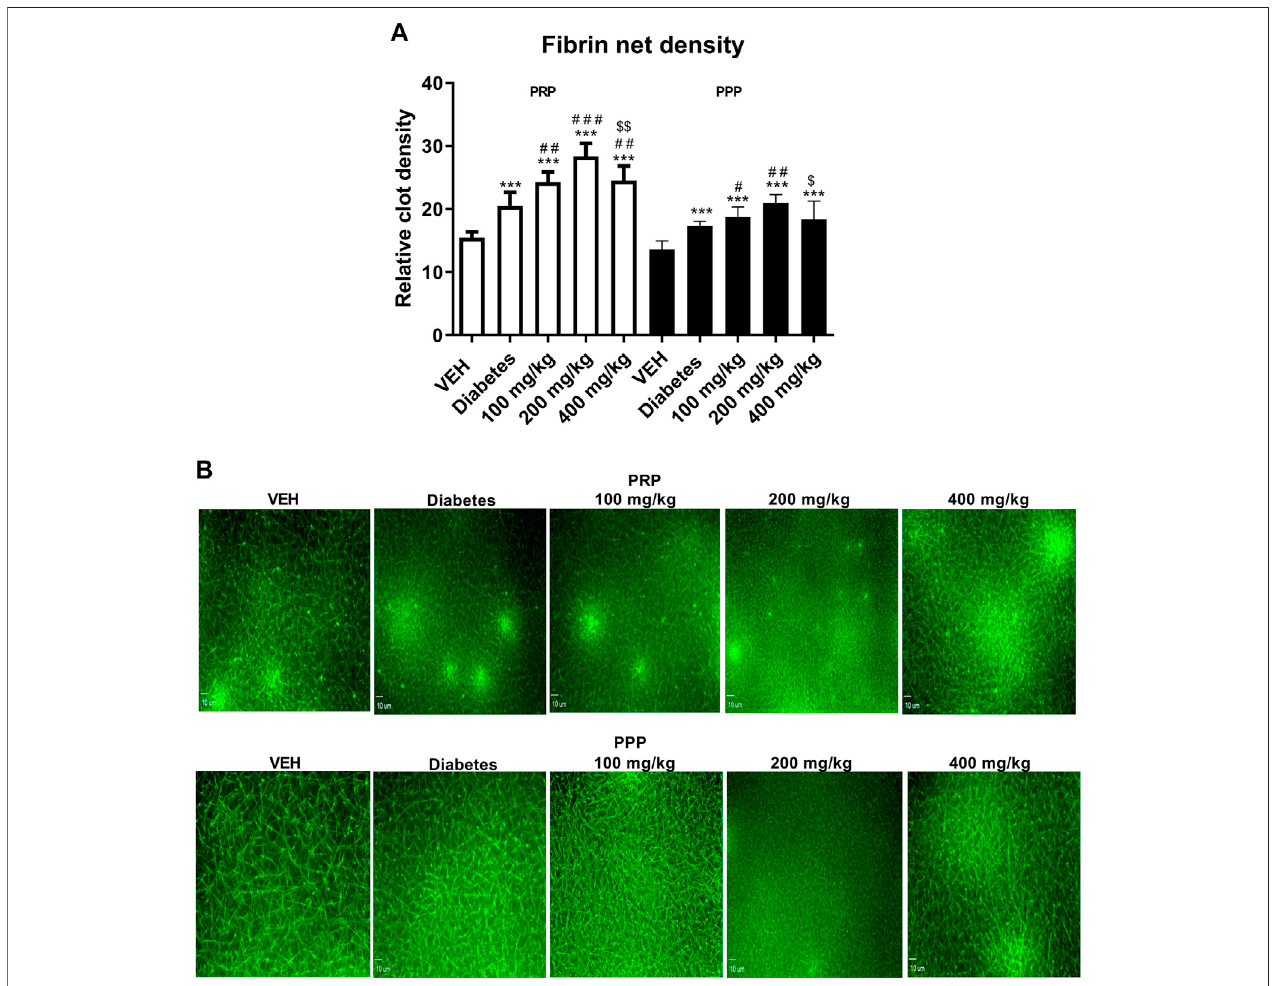
FIGURE 7 | The effect of TE on the fi brin net density in clots formed after recalcination of PRP (white bars) and PPP (black bars) (A) . Representative confocal microscopyimagesof fi brinnet.Bar (cid:2) 10 µm (B) .*** p < 0.001vs.VEH;# p < 0.05,## p < 0.01,### p < 0.001vs.Diabetes;$ p < 0.05,$$ p < 0.01vs.200 mg/kg; n (cid:2) 7 – 9. Data are shown as mean ±